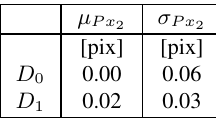
, σ Px – the mean and standard deviation 2 2